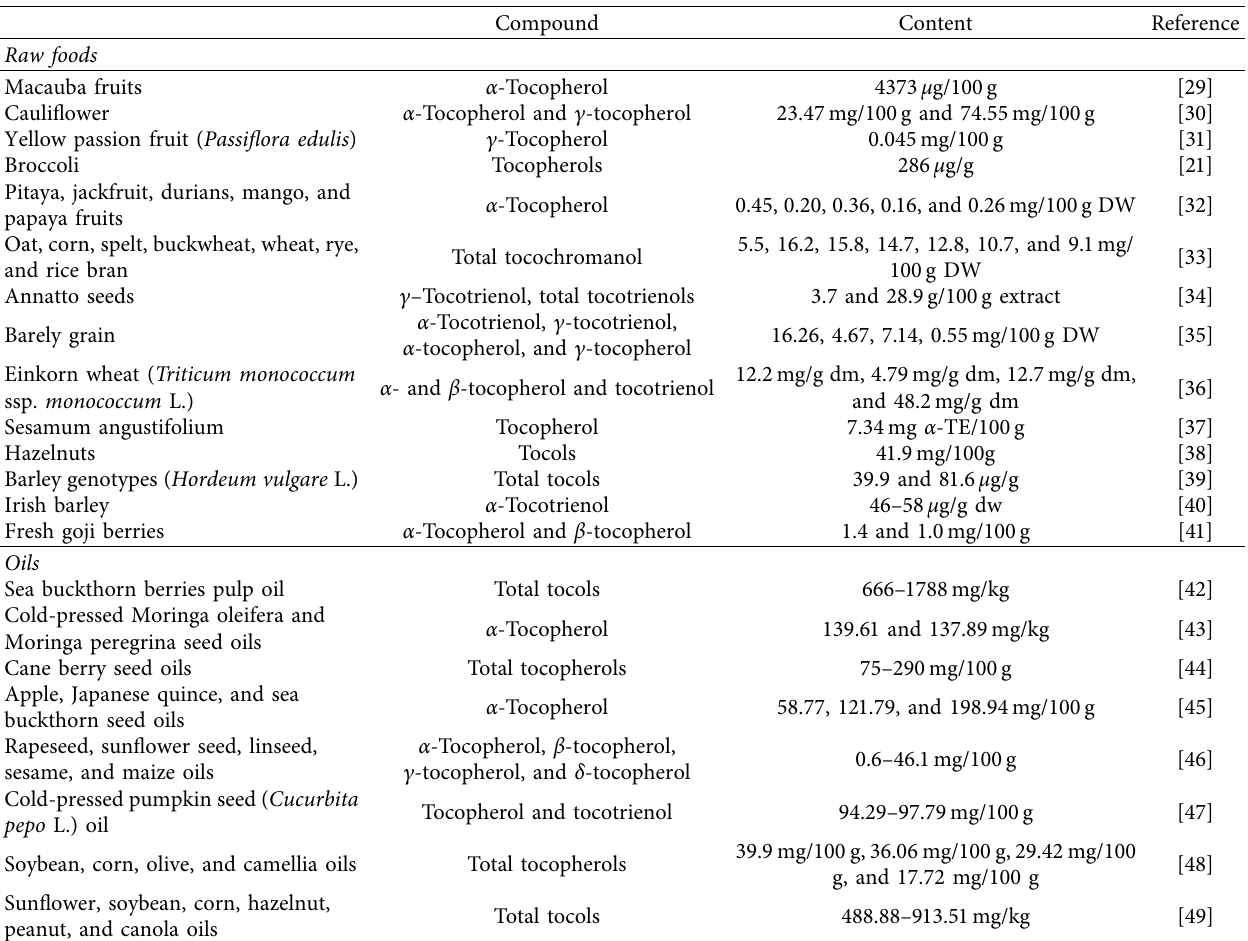
Table 1: Levels of tocols in different